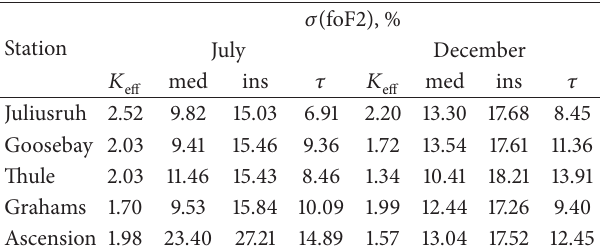
Table 1: An average for all years of correspondence between model and experimental foF2 values.